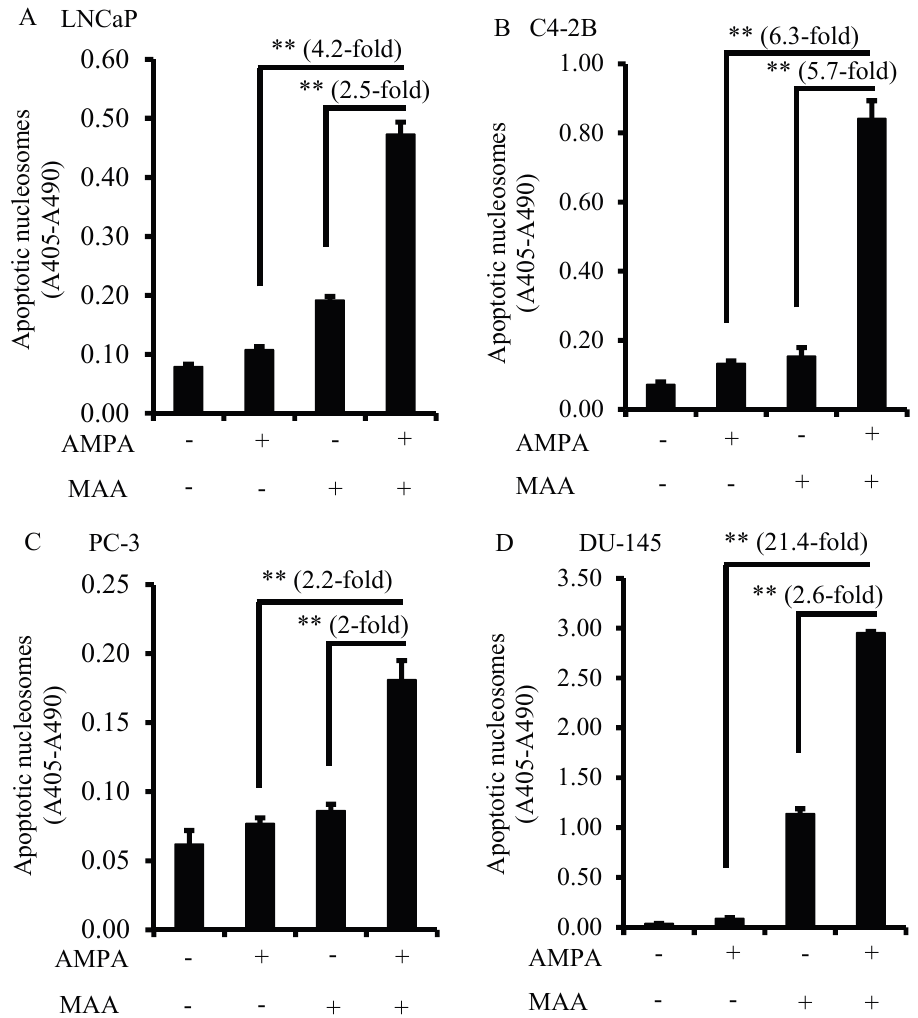
Figure 2. The AMPA and MAA combination induces apoptosis in prostate cancer cells. ( A – D ) Prostate cancer cells were plated in 12-well plates in triplicate per group and treated with 15 mM AMPA, 5 mM MAA and a combination of AMPA and MAA for 24 h. Apoptotic nucleosomes were measured using the Cell Death Detection ELISA kit. Apoptotic nucleosomes were calculated by absorbance at 405 nm (A405) minus absorbance at 490 nm (A490). The data are presented as the mean ± SEM of three independent experiments ( n = 3). ** p <